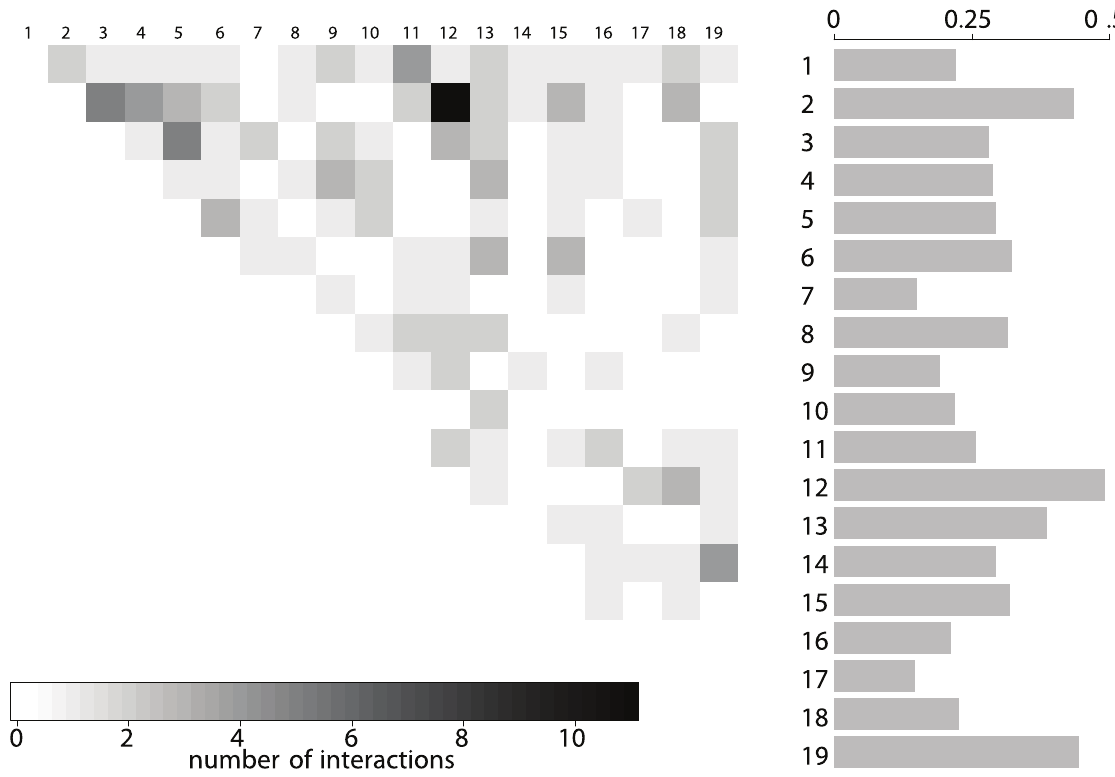
Figure 3. Number of interactions per autosome pair. Results are based on the 168 significant LD block pairs involving 272 loci. The barplot on the right shows the average number of interactions per LD block for each chromosome. Chromosomes 2 , 12 , and 19 show the highest participation in interactions while the fewest interactions per LD block are on chromosome 17 .